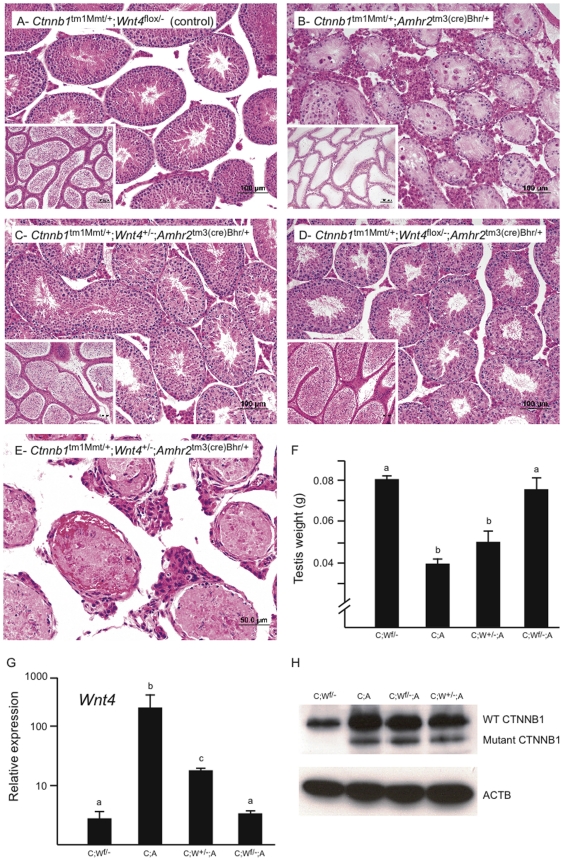
WNT4 acts downstream of CTNNB1 to cause germ cell loss in vivo.(A–D) Photomicrographs of testes from 8 week-old animals of the indicated genotypes. Insets show sections of epididymides from the corresponding animals. (E) Photomicrograph of a testis of the indicated genotype showing the severe testicular degeneration, coagulation necrosis and intratubular hemorrhage phenotypes described in the text. (F) Testis weights from 8 week-old animals of the indicated genotypes, n = 4 animals/genotype. C;Wf/−: Ctnnb1
tm1Mmt/+;Wnt4
flox/− (control), C;A: Ctnnb1
tm1Mmt/+;Amhr2
tm3(cre)Bhr/+, C;W+/−;A: Ctnnb1
tm1Mmt/+;Wnt4
+/−;Amhr2
tm3(cre)Bhr/+, C;Wf/−;A: Ctnnb1
tm1Mmt/+;Wnt4
flox/−;Amhr2
tm3(cre)Bhr/+. (G) Wnt4 mRNA levels in the mice described in panel F. Note the logarithmic scale on the Y axis. (H) CTNNB1 immunoblot analyses of testes from 8 week-old animals of the indicate genotypes. The lower band corresponds to the dominant-stable CTNNB1 mutant protein produced by the recombined Ctnnb1
tm1Mmt/+ allele. ACTB was used as a loading control. Animals showing the severe degenerative phenotype described in the text and shown in panel E were excluded from the data analyses shown in panels F–H. All data are expressed as mean (columns) ± SEM (error bars). Groups labeled with different letters (a, b, c) were significantly different (P<0.05).